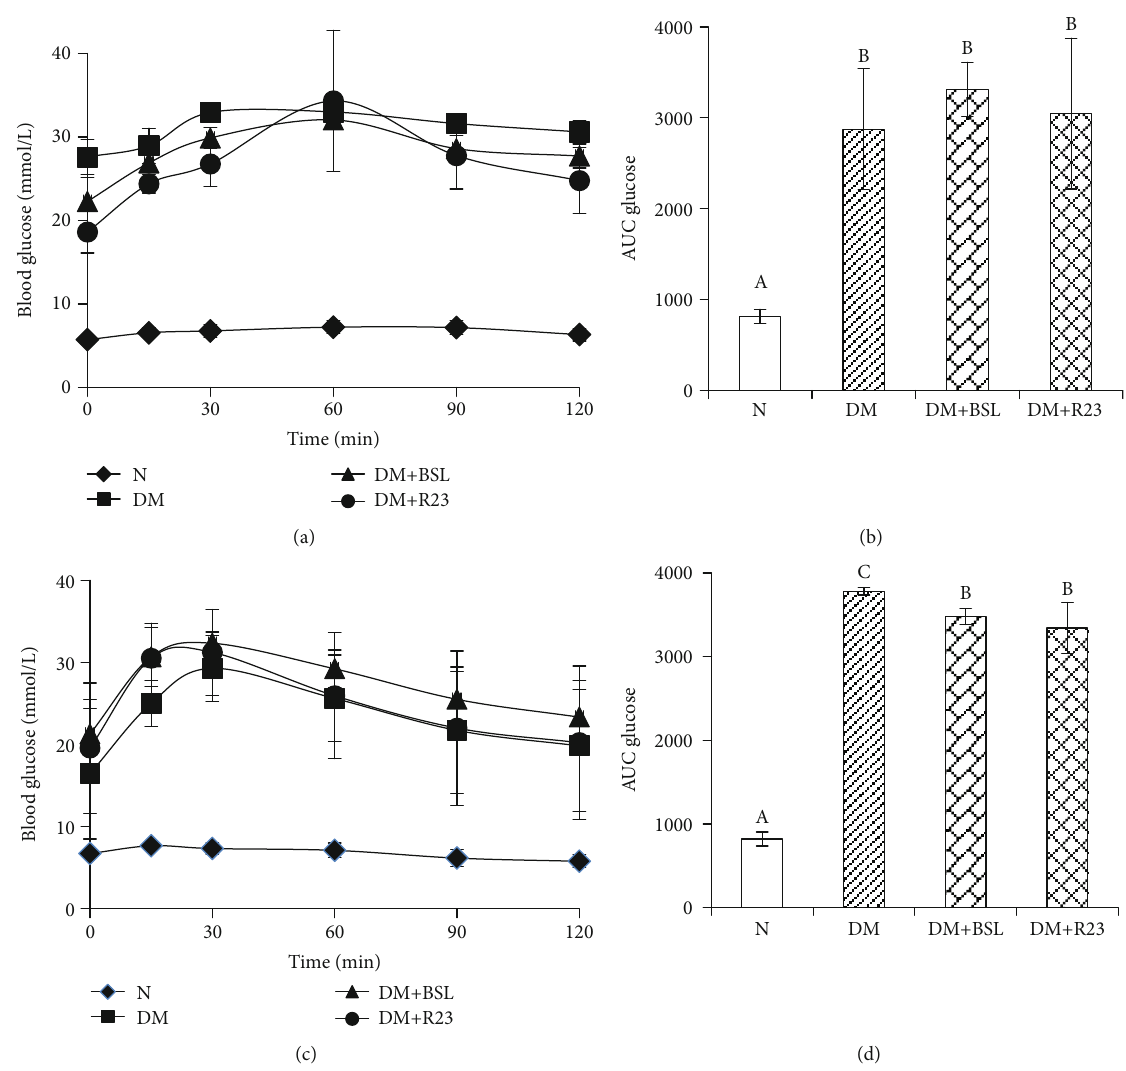
Figure 3: E ff ect of L. rhamnosus BSL and L. rhamnosus R23 on OGTT at day 0 (a) and day 30 (c); AUC glucose at day 0 (b) and day 30 (d). The values are expressed as the means ± SD ( n = 6 ). The values with di ff erent superscript letters are signi fi cantly di ff erent ( P < 0 : 05